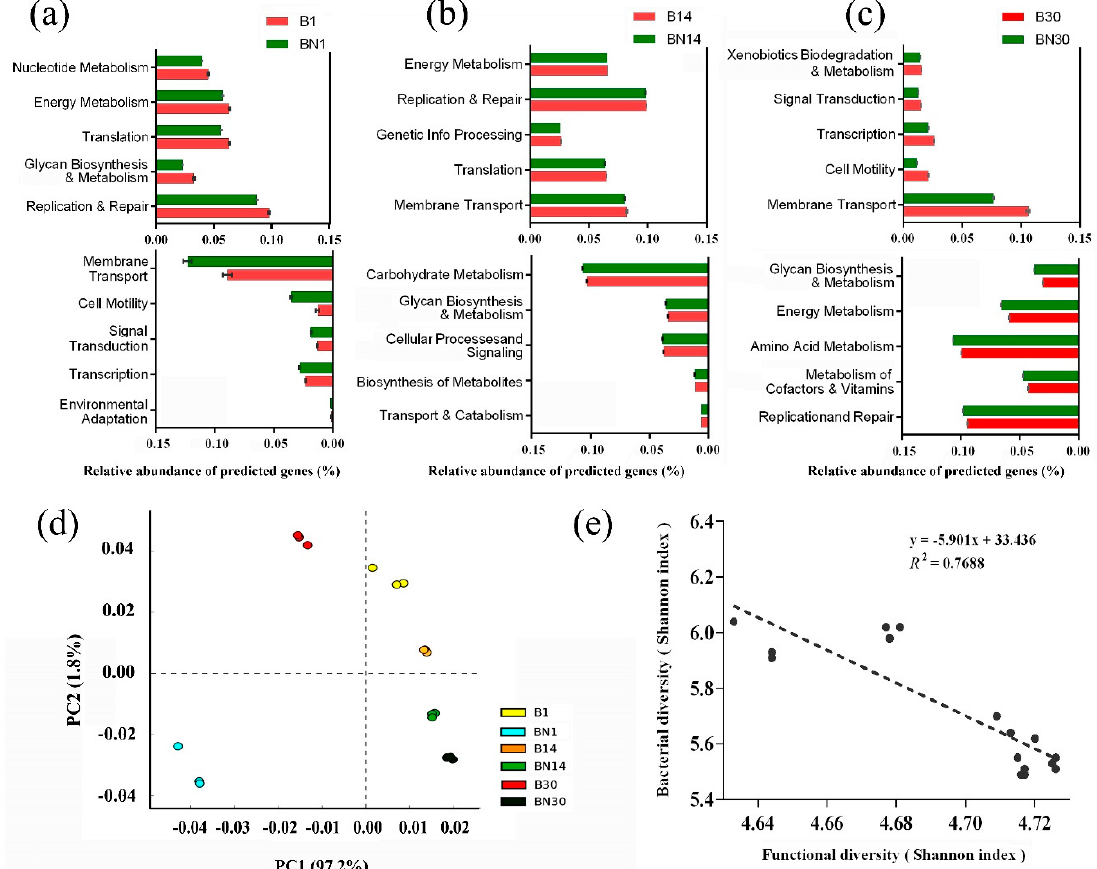
Figure 4. Variation in gut bacterial functional profiles in the pup normal and nude BALB/c mice at different time points. ( a – c ) The bar plots show the most significantly enriched differential bacterial genes in the two types of mice samples on day 1, day 14 and day 30, respectively. Significant differences are all obtained from displayed genes (determined by independent t-test, p < 0.05). ( d ) Regression analysis showed significant correlation between bacterial diversity and functional diversity in all samples. ( e ) The principal component analysis (PCA) plot indicated functional shifts in the gut microbial